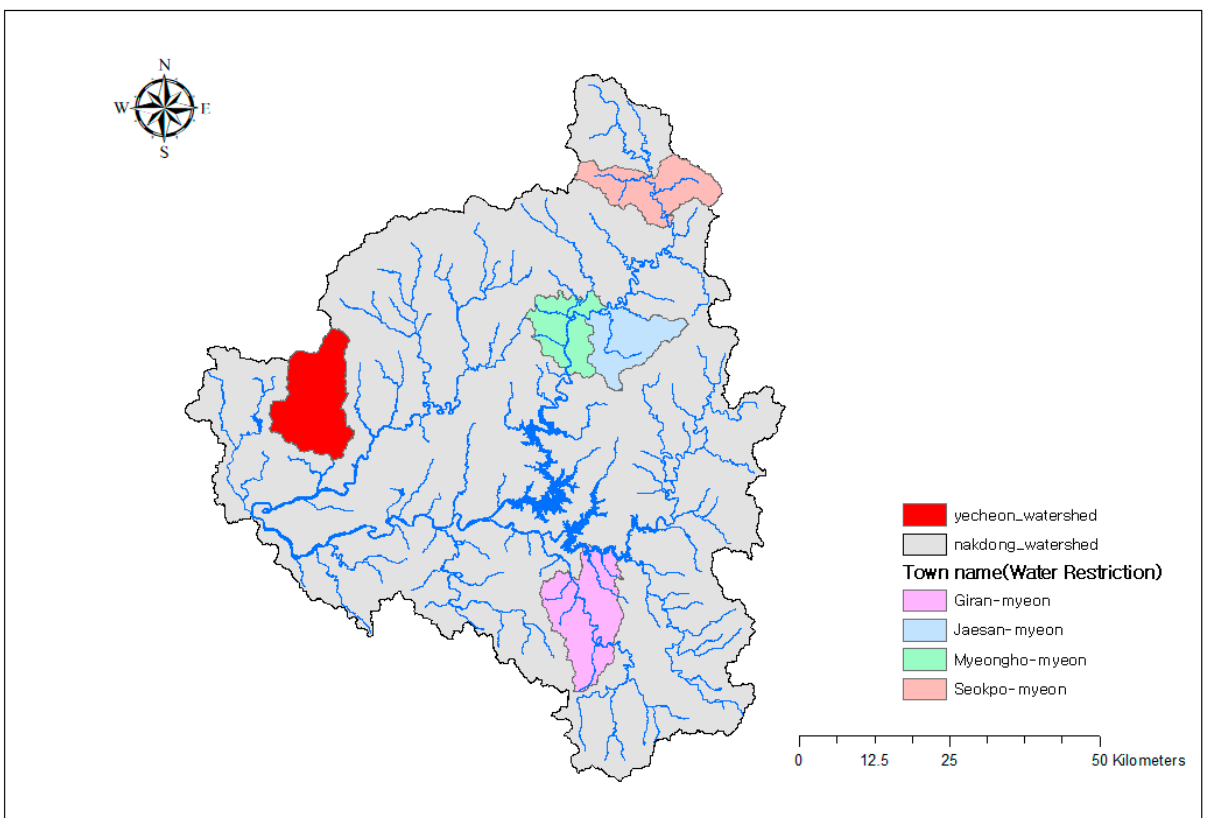
Figure 13. Geographic Information System (GIS) map of damages from the water restriction at Nakdong River Basin covering the study area.